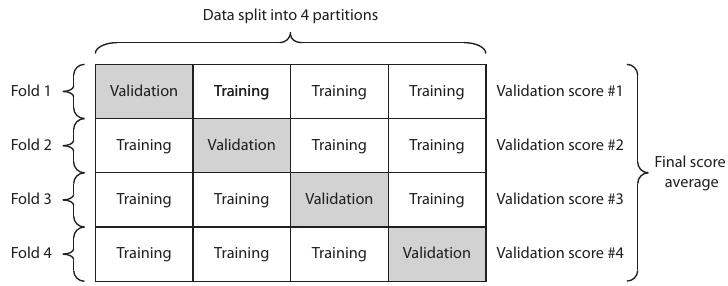
Figure 14. K-fold cross-validation method (K = 4).